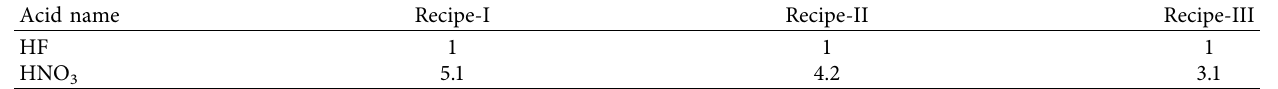
Table 1: Different recipes of HF :HNO